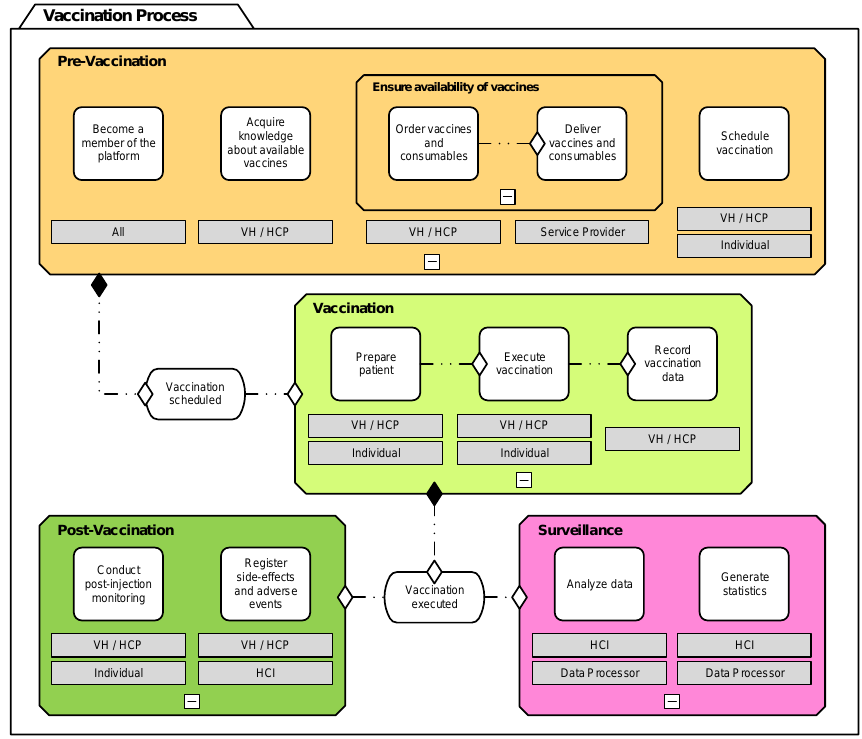
Figure 8. High-level overview of interactions supported by the COVID-19-Vacc